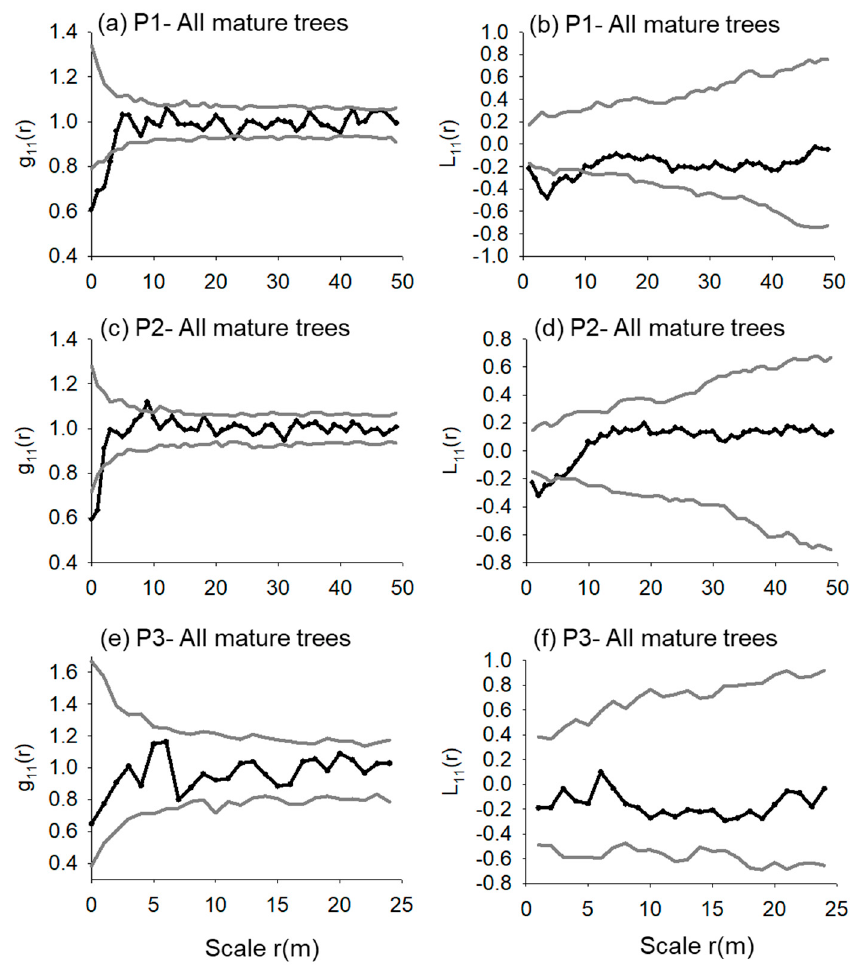
Figure A1. Spatial patterns of all mature trees with DBH ≥ 10 cm in three plots (P1, P2, and P3) using univariate pair-correlation g-function ( a , c , e ) and L-function ( b , d , f ). Null models used complete spatial randomness (CSR). In all three plots, the g-function and L-function showed no large-scale departure from the null model of CSR, which indicated environmental homogeneity. Particularly in P1 and P2, the g-function ( < 1) and L-function ( < 0) were significant for scales smaller than 10 m, as they did not approach value 0 under the null model of CSR. Moreover, the spatial arrangement of mature trees in P3 fit very well under the null model of CSR when analyzed by the g- and L-functions. These evidences significantly exhibited a large scale of environmental homogeneity at P1, P2, and P3. Note: L-function is a transformation of Ripley’s K-function (L(r) = (K(r) / π ) 0.5 − r). The g pair-correlation function is the derivative of the K function g(r) = K’(r) / (2 π r) and r is the circle’s radius from a randomly chosen tree. Black lines are observed patterns; grey lines are approximately 95% confidence envelopes.